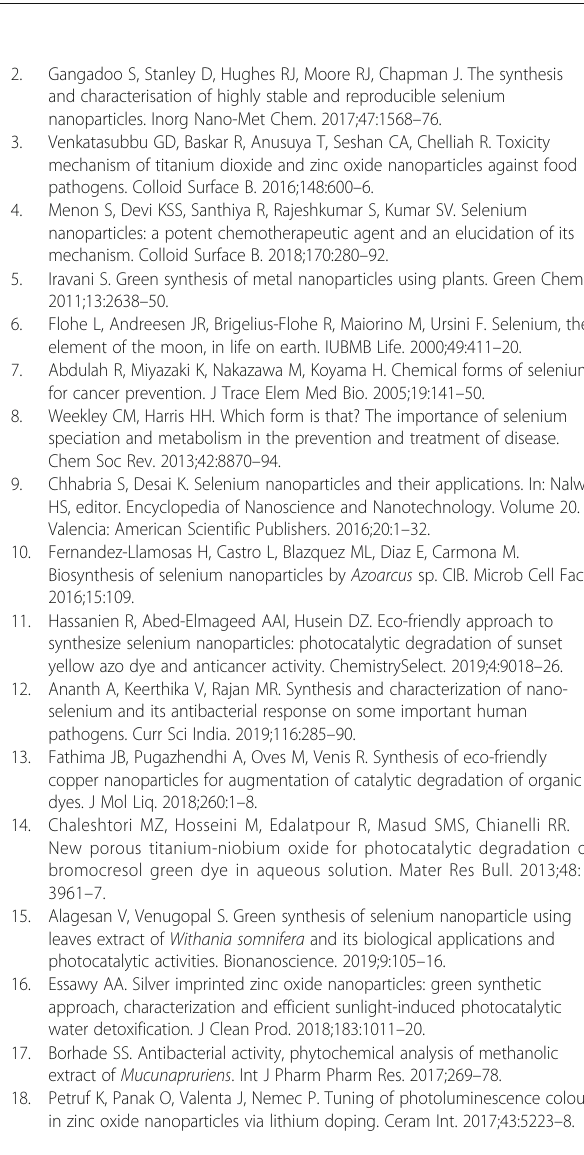
Fig. 11 Antimicrobial efficiency of biosynthesized SeNPs on removal of pathogens from lake